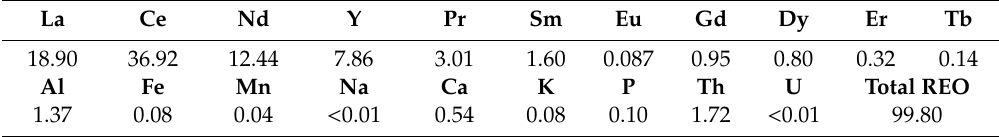
Table 8. ICP-OES analysis of the obtained product.